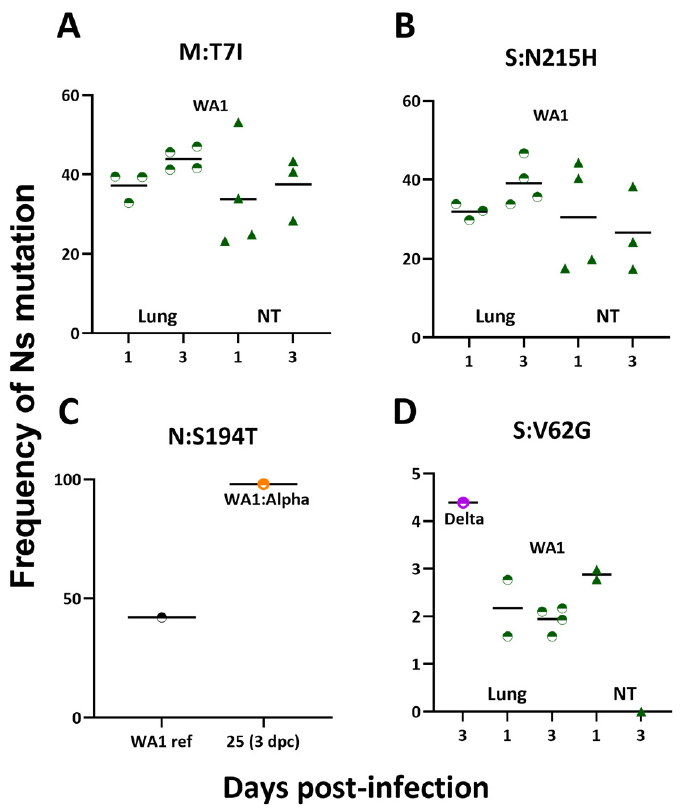
Figure 5. Nonsynonymous mutations in lungs and/or nasal turbinates at 1 and 3 days postinfection or postchallenge. The frequencies of nonsynonymous mutations that were noted in the lung and nasal turbinate (NT) for WA1-infected mice ( A , B , D ), Delta-infected mice ( D ), and WA1-infected:Alpha-challenged mice ( C ). ( A ) M:T7I was detected in WA1-infected mice 1 and 3 days postinfection (dpi) in the lung and nasal turbinate (NT). ( B ) S:N215H was detected in WA1-infected mice 1 and 3 dpi in lung and nasal turbinate. ( C ) N:S194T was detected in our WA1 stock at just under 50% as well as in one Alpha-challenged mouse at just under 100% frequency. ( D ) S:V62G was found in lungs and NT of WA1-mice 1 and 3 dpi and in the lung of a Delta-infected mouse 3 dpi. Abbrevia- tions: ref—reference; NT—nasal turbinate; dpi—days postinfection; dpc—days postchallenge.